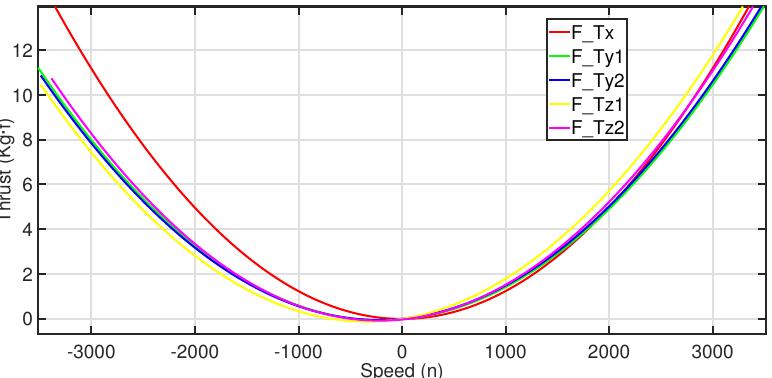
Figure 6. Schematic diagram of thrust